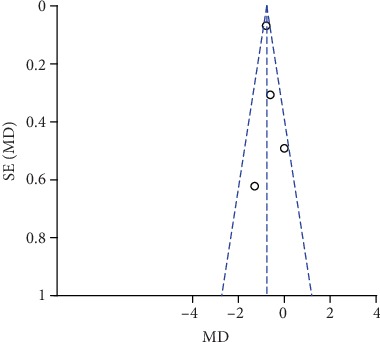
Funnel plot of pain scores at rest at 12 h.